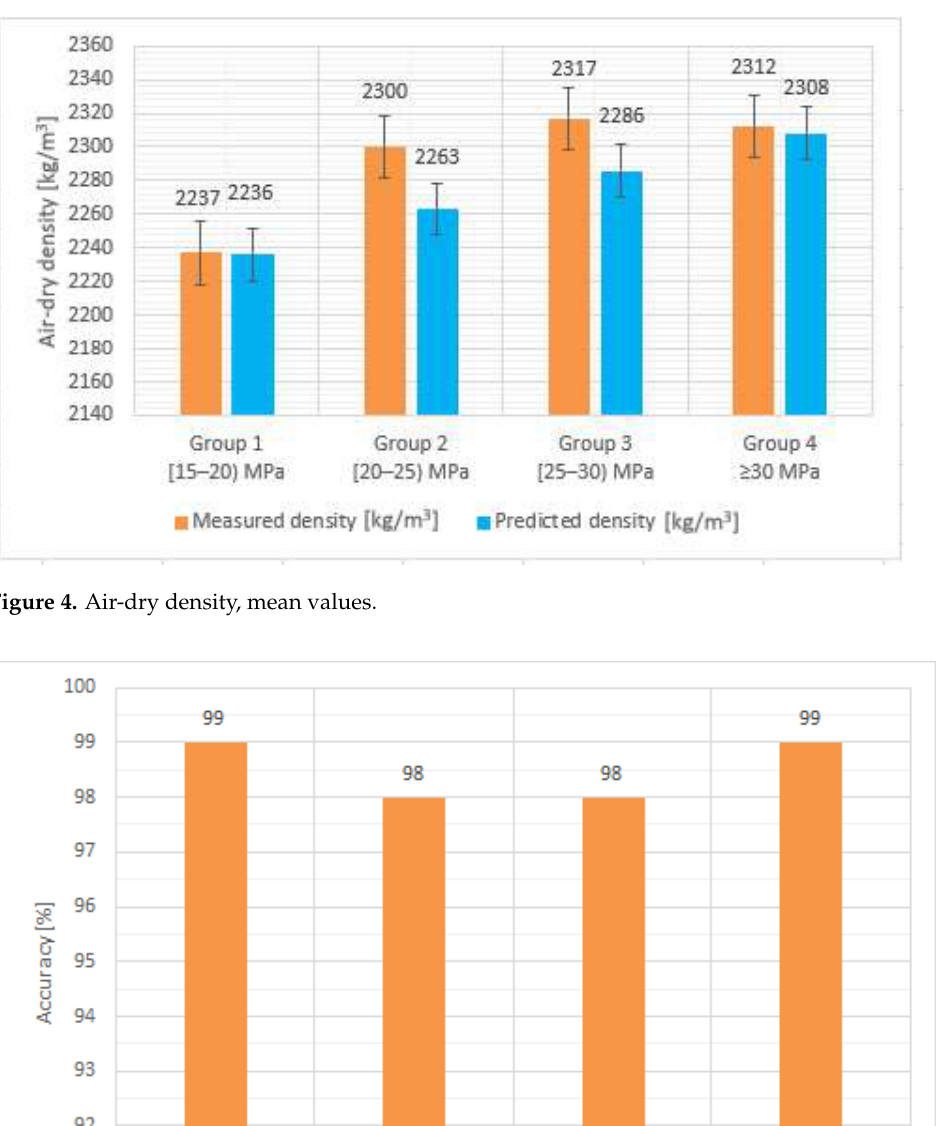
Table 2. Compressive strength.